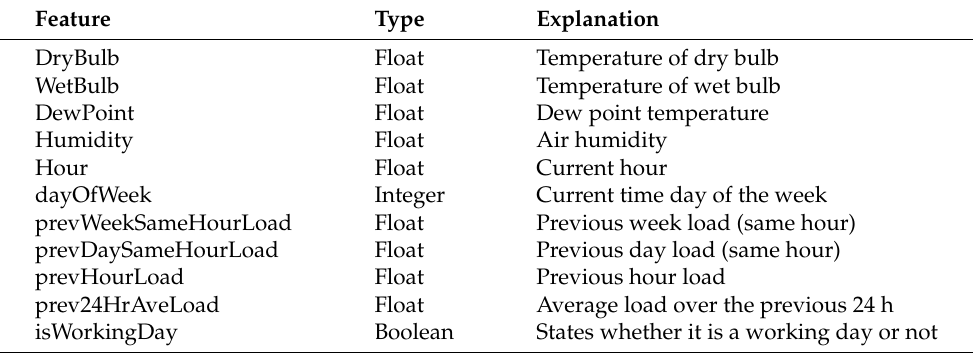
Table 1. List of features that characterise the available data, for both residential and enterprise